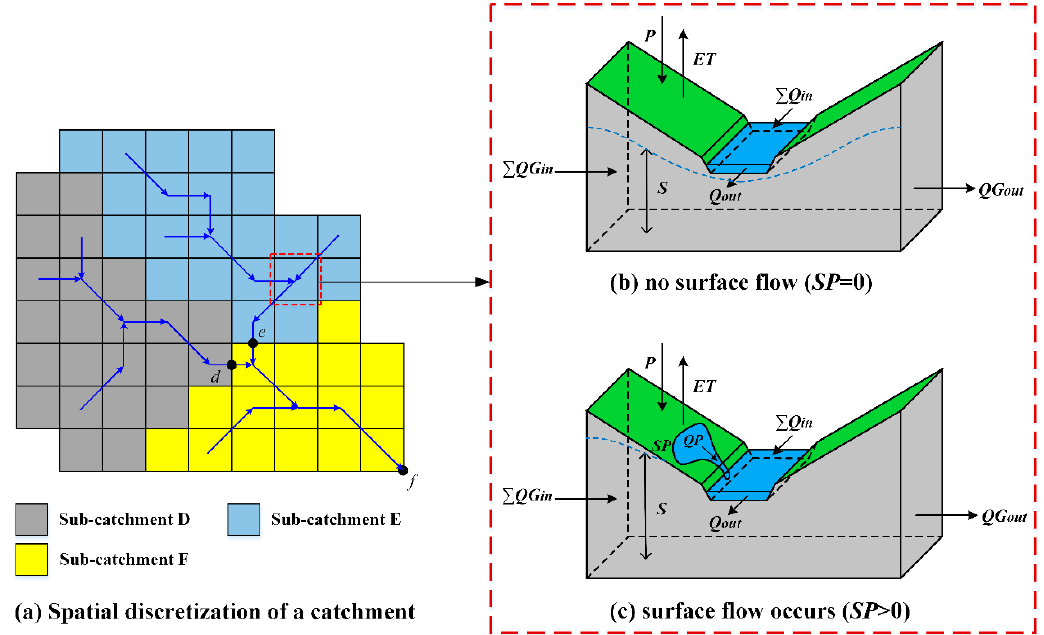
Figure 2. The spatial discretization strategy and water balance components for a basic hydrological response unit (cell) within DEM-based distributed rainfall-runoff model (DDRM): ( a ) discretization of a catchment into sub-catchments and cells; ( b ) situation where the cell is not saturated, and no surface flow occurs; ( c ) situation where the cell is saturated and surface flow occurs.